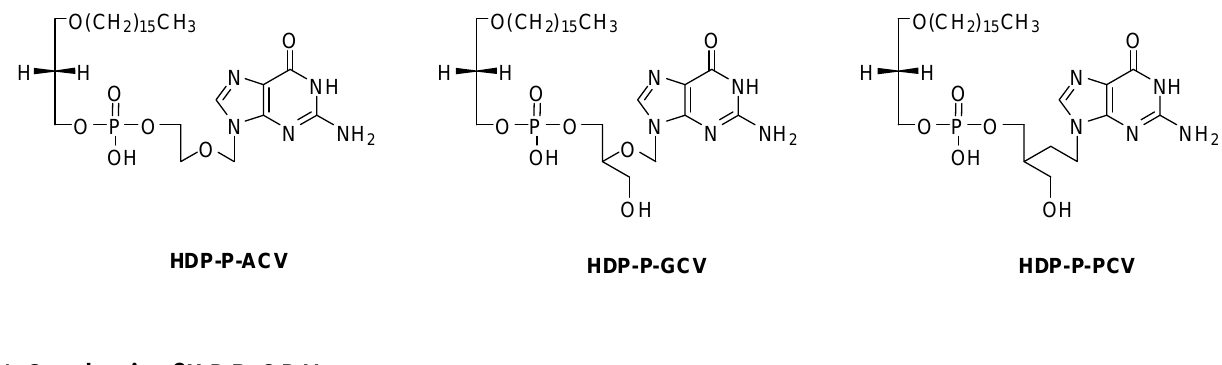
Figure 1. Structure of HDP-P esters of Acyclovir, Ganciclovir and